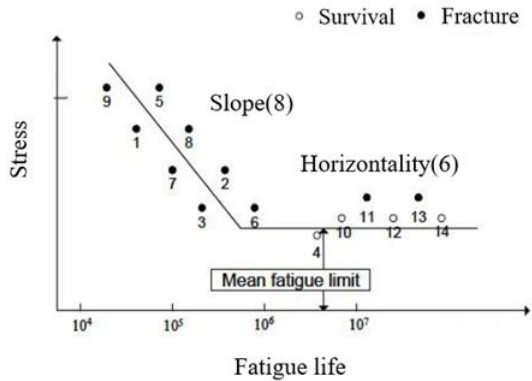
Figure 12. Statistical fatigue test of the S–N method.